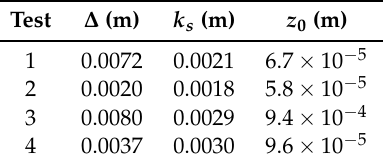
Table 4. Parameters describing the log-law for Scenario 2, where κ = 0.405 and B = 8.5.